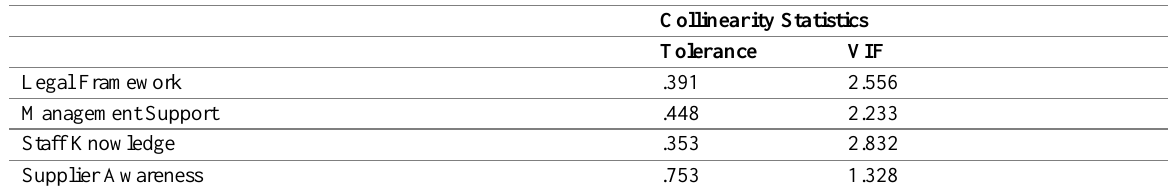
Table 2: Multi-Collinearity Test Result